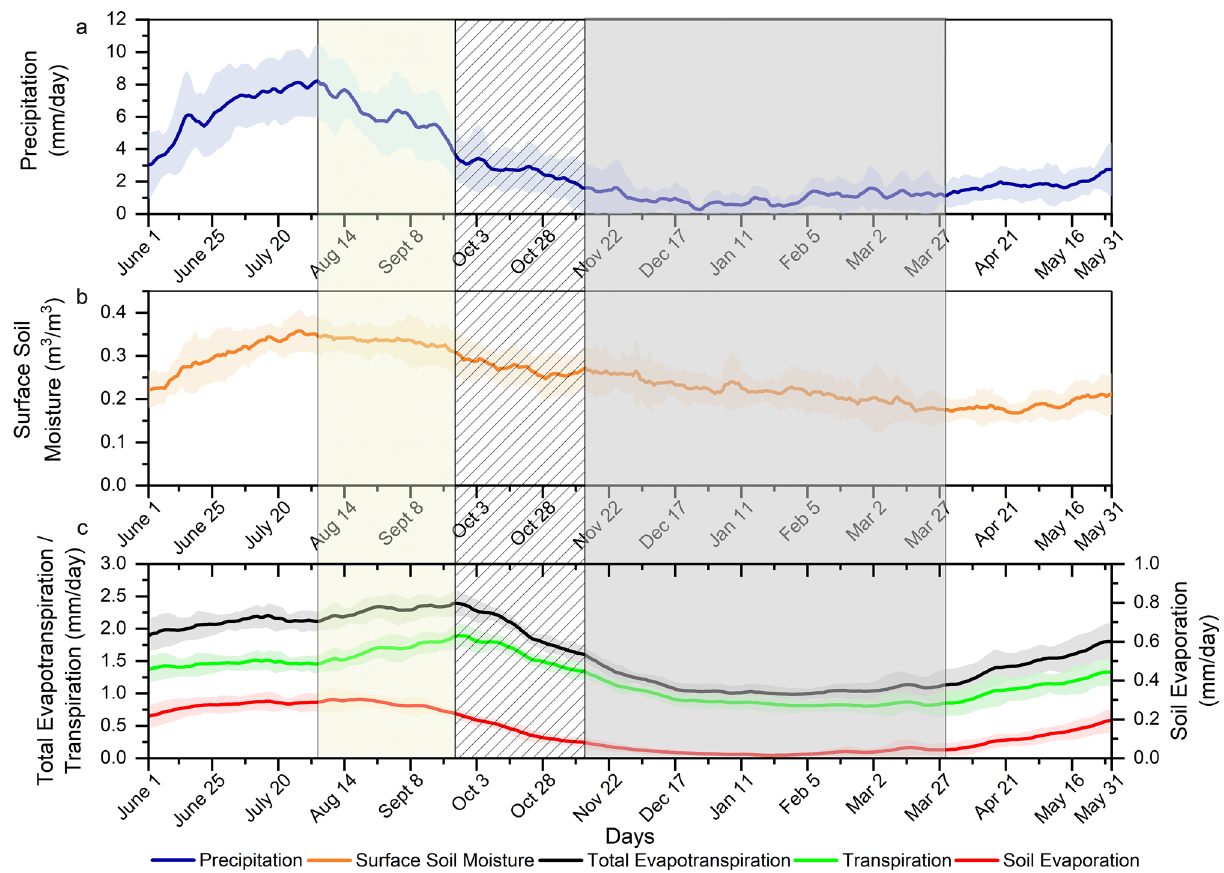
Figure 1. Climatology of observed variables: ( a ) Precipitation, ( b ) Surface Soil Moisture, ( c ) Evapotranspiration and its components for the period 2001 to 2015. The yellow, hatched and grey shaded regions correspond to the delayed response period, pre-capacitor period and capacitor period, respectively. The plots are prepared in Origin surplus condition. The precipitation during this period accounts for almost 28% of the total annual precipitation, whereas the ET is approximately 20% of the total annual ET. The daily average incoming radiation is 97% of its annual daily average, meeting the plant demands. The delayed response period lasts for approximately 50 days when spatially averaged over the Indian landmass. The second period (hatched in figures) is the time interval during which ET drops from its peak and precipitation still exceeds ET. We define it as the pre-capacitor period. The pre-capacitor period, which extends for approximately 50 days (based on the climatology of spatial means), witnesses a drop in both precipitation rate (57%) and radiation (18%), leading to a decrease in ET (33%), from the start of the pre-capacitor period. However, the decline in ET is slower than that of precipitation. The total ET during the pre-capacitor period accounts for approximately 17% of total annual ET against a precipitation input of 12% of total annual precipitation. The third period, i.e., the capacitor period (grey shaded in figures), is the phase during which the ET is higher than precipitation. While both precipitation and ET rates decline by approximately 29% when spatially averaged across the Indian landmass, ET during the capacitor period